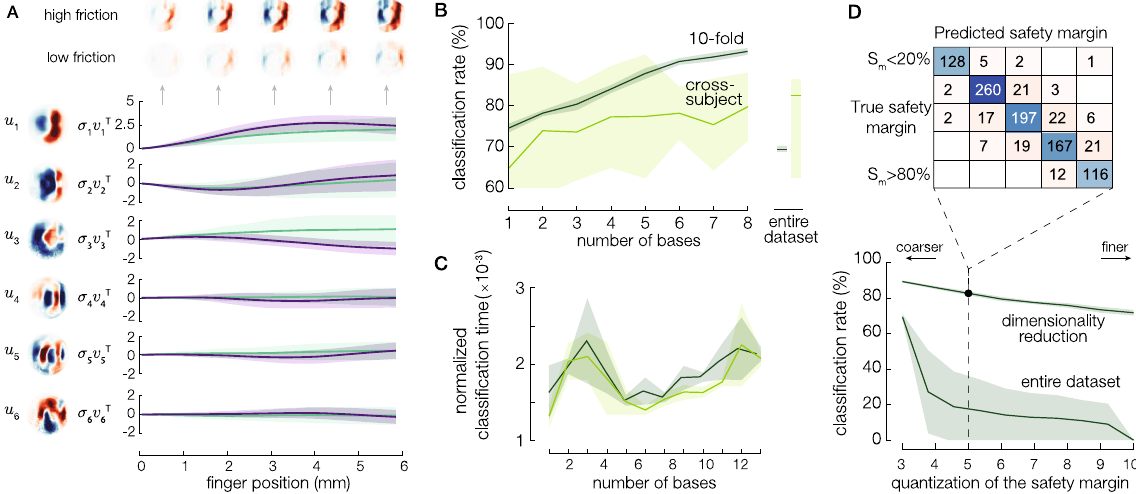
Figure 4. ( A ) Six first bases u i and the temporal evolution of the recruitment of these six bases for a low and a high-friction condition (in violet and green, respectively). ( B ) The classification rate of the safety margin is split into two classes, as a function of the number of bases. The dark green line corresponds to ten-fold testing when taking 90% of the data for training and 10% for testing, and the light green line corresponds to cross-subject testing when only one subject among 14 is used for testing. The solid lines and shaded areas stand for mean ± std. Classification rates using the entire strain matrix ǫ are represented on the right. ( C ) The time needed for the classification using (cid:31) V normalized by the time using the whole matrix of strains for the cross-subject and the 10-fold classifier. ( D ) Effect of safety margin quantization on the classification rate when using 6 bases for the decomposition. The confusion matrix is shown for 5